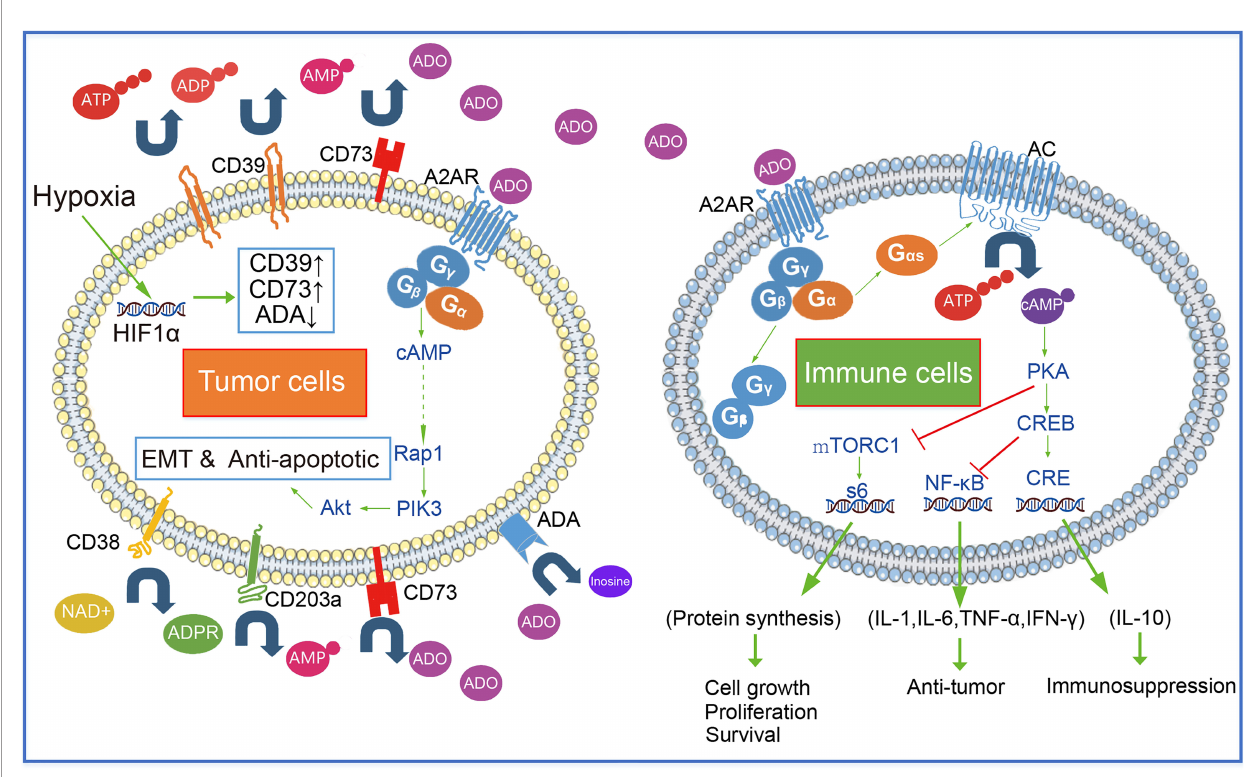
FIGURE 2 | Extracellular adenosine- A2AR signal pathway in tumor and immune